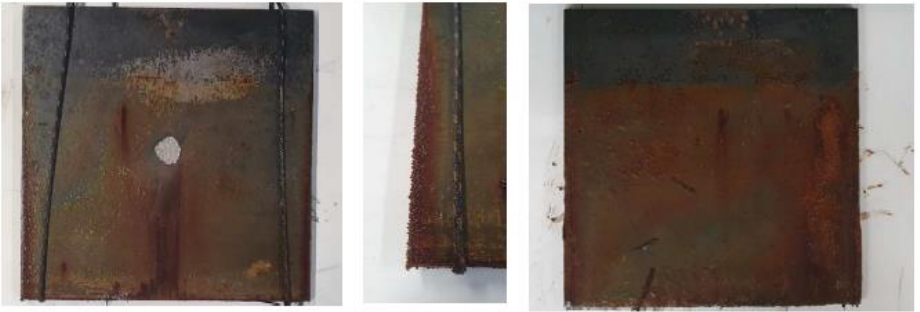
Figure 9. Baseplate after 3 weeks of accelerated corrosion.